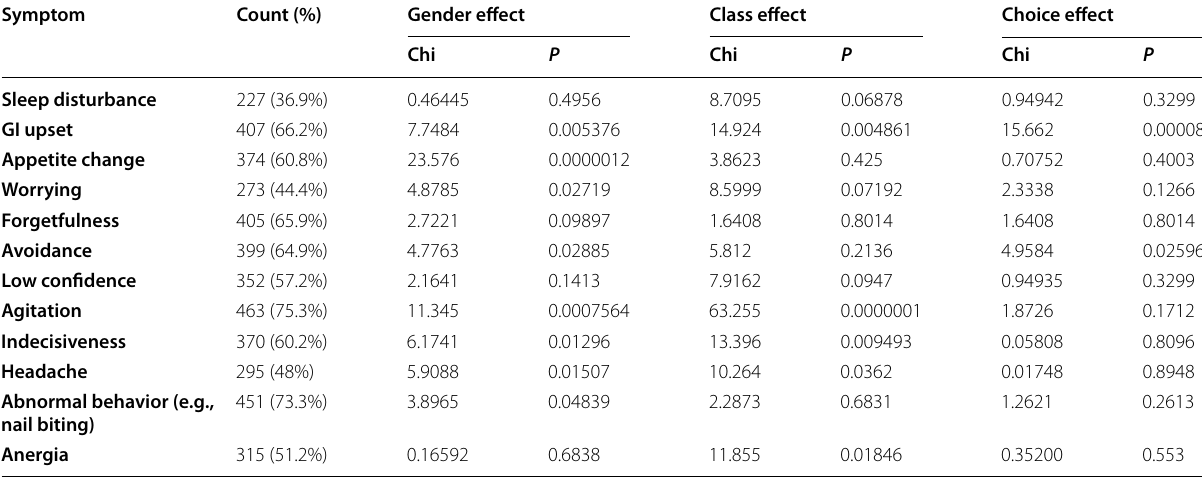
Table 3 The effect of gender, choices and class using generalized linear Poisson regression model